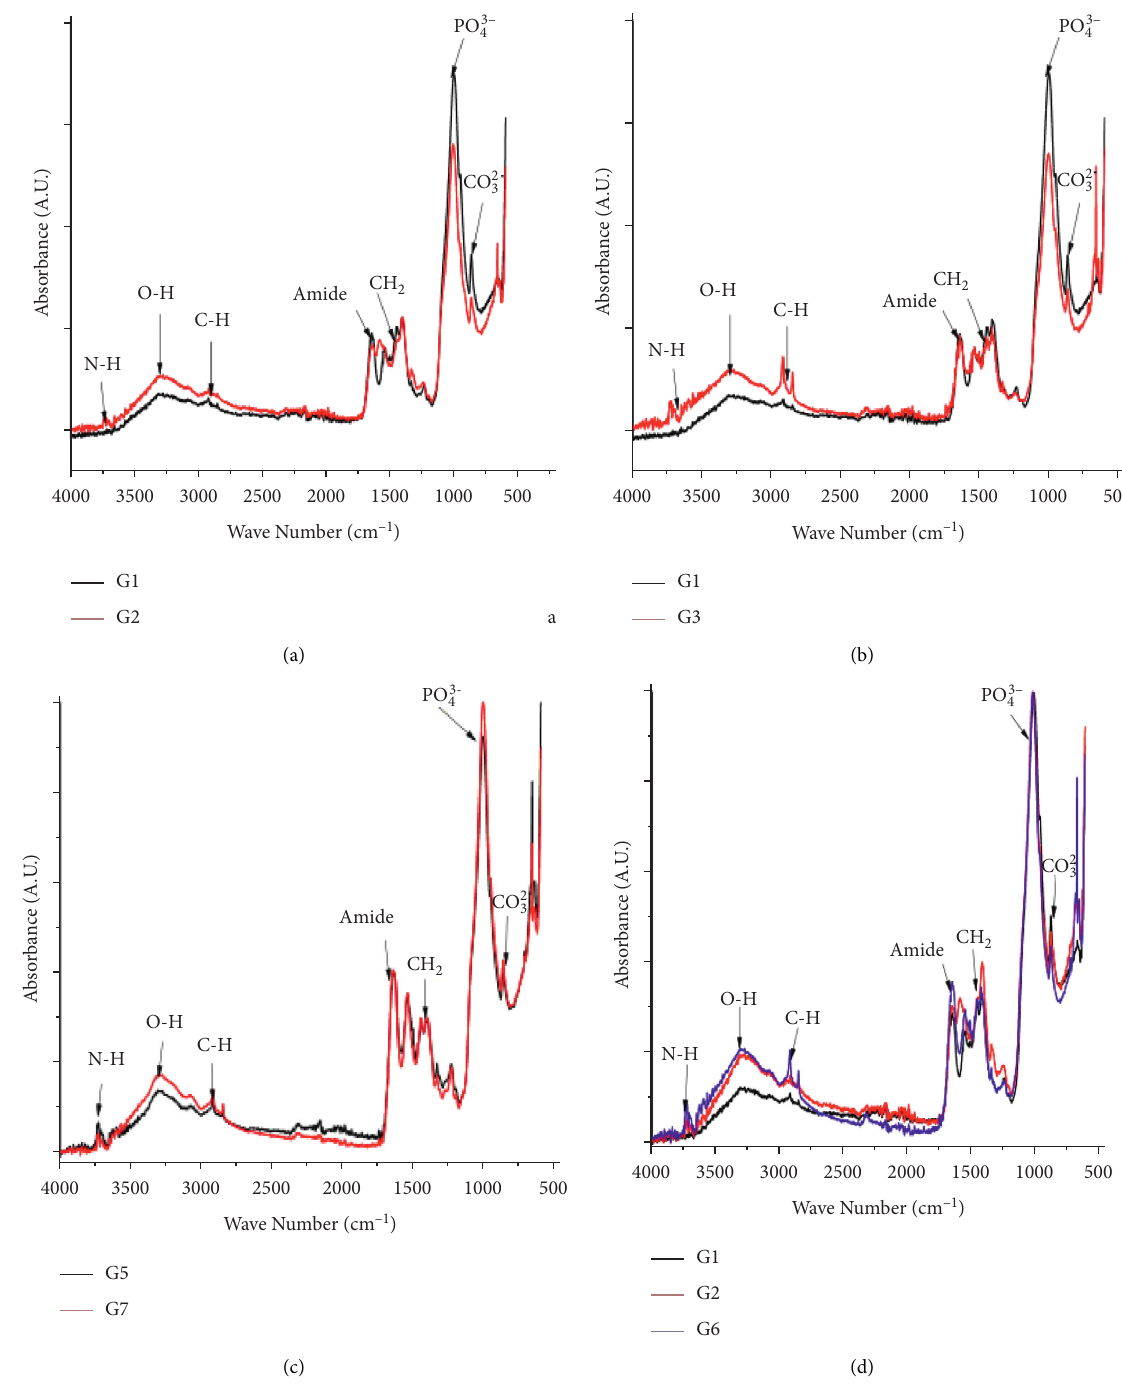
Figure 5: IR representative spectrum. Inorganic phase: phosphate/carbonate ions and the organic phase: amide bands and methyl groups. (a) Negative control and 1% NaOCl+17% EDTA. (b) Negative control and 0.025% HCOl. (c) Experimental groups 0.2% CS and CSnp. (d) Comparative infrared spectrum between negative control [1% NaOCl +17% EDTA] and [1% NaOCl +0.2%